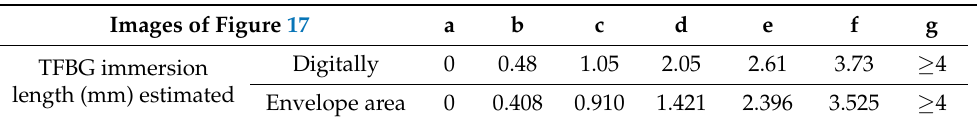
Table 4. The TFBG immersion length in the RI liquid estimated from the images of Figure 17 and through the envelope areas.